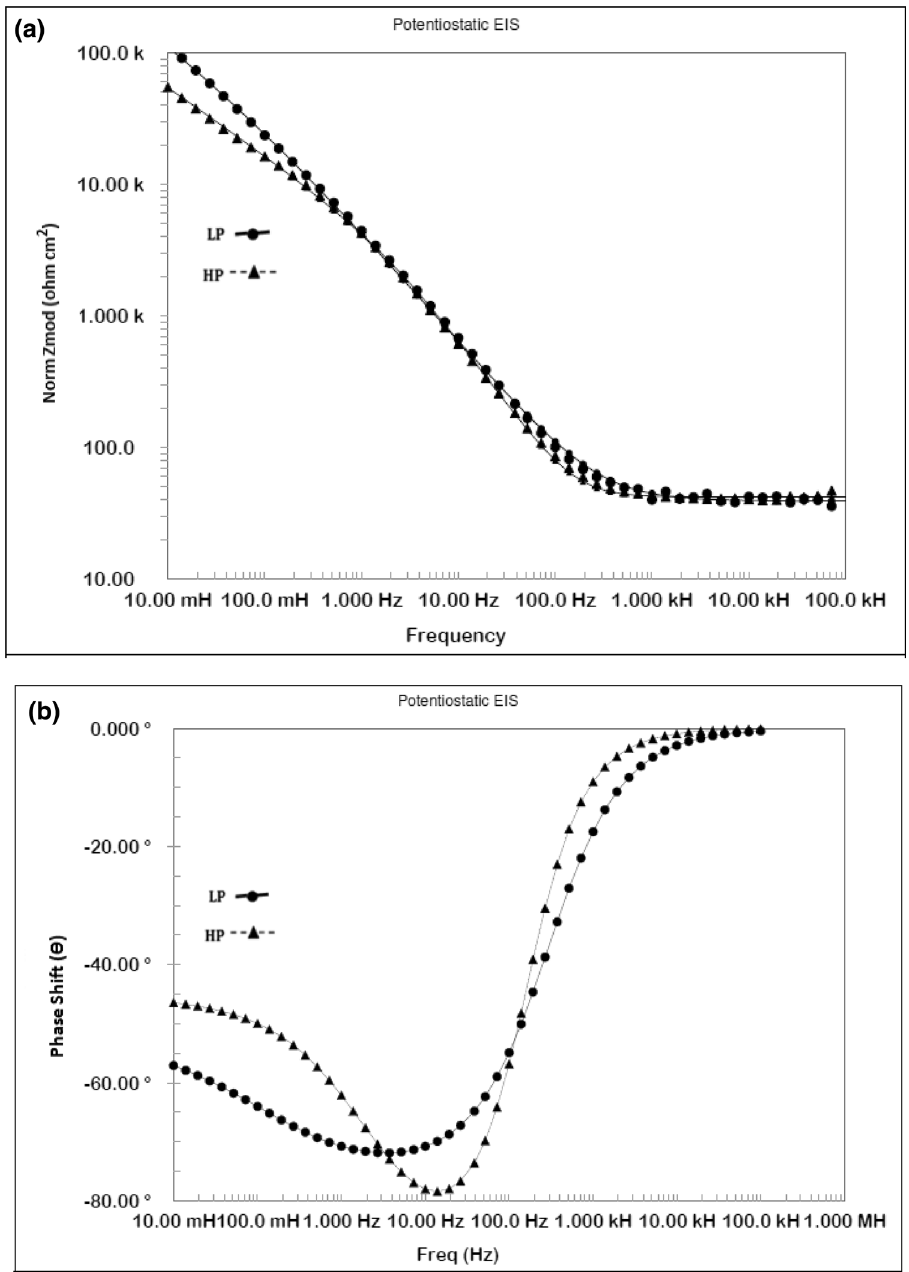
Figure 11. ( a ) Electrochemical frequency–impedance Bode plots for HP and LP steel bars after 192 h of their exposure in chloride free SPSL. ( b ) Electrochemical frequency–phase shift Bode plots for HP and LP steel bars after 192 h of their exposure in chloride free